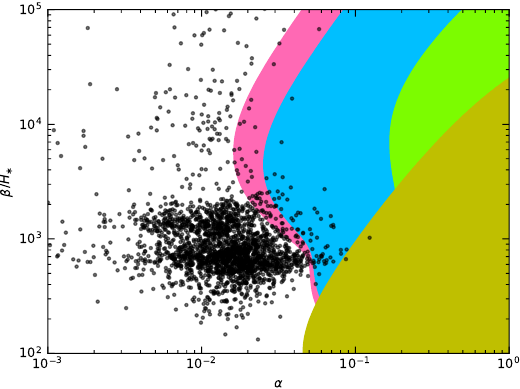
Figure 16 . The pink, blue, yellow, and green regions represent respectively the sensitivities of BBO, DECIGO, LISA, and B-DECIGO exceeding the detection threshold, assuming the nucle- ation temperature T n = 200 GeV. The scatter points are the samples that both generate a strong (cid:12)rst- order EWPT and survive the collider searches and DM experiments. The gauge-independent potential is adopted for the calculations.